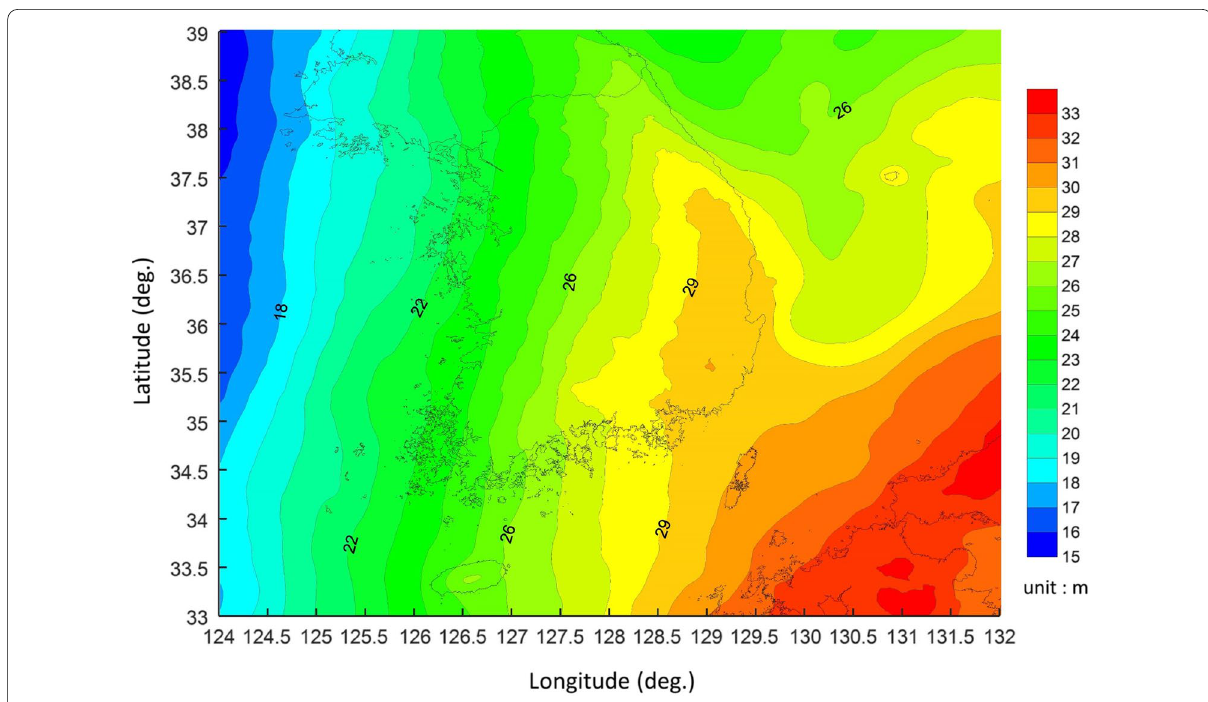
Fig. 7 KNGeoid18 (Kwon et al. 2018)